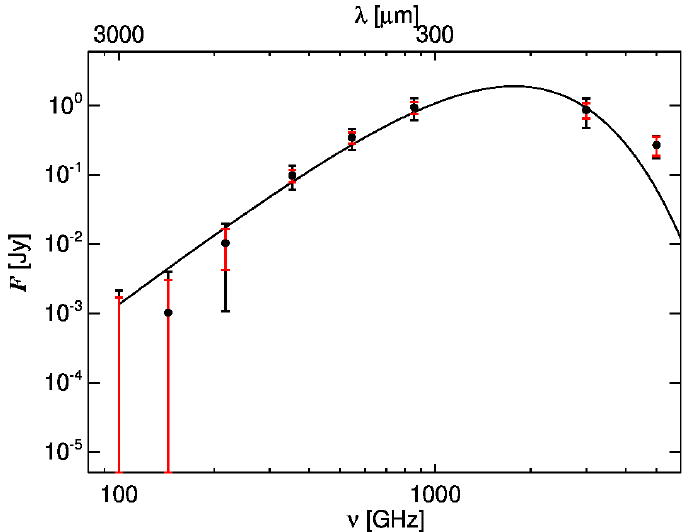
Figure 2. The cumulative spectrum averaged over the sample of 645 clusters with known redshifts z (cid:39) 0.1–1 (black points); black error bars show the dispersion from a bootstrap resampling, while the red ones are obtained by integration at random positions 1 ◦ away from each cluster region. The solid black line shows the best-fit modified blackbody spectrum with the spectral index β = 1.5. Credit: Planck collaboration [39]. A&A, 596, A104, 2016, reproduced with permission ©